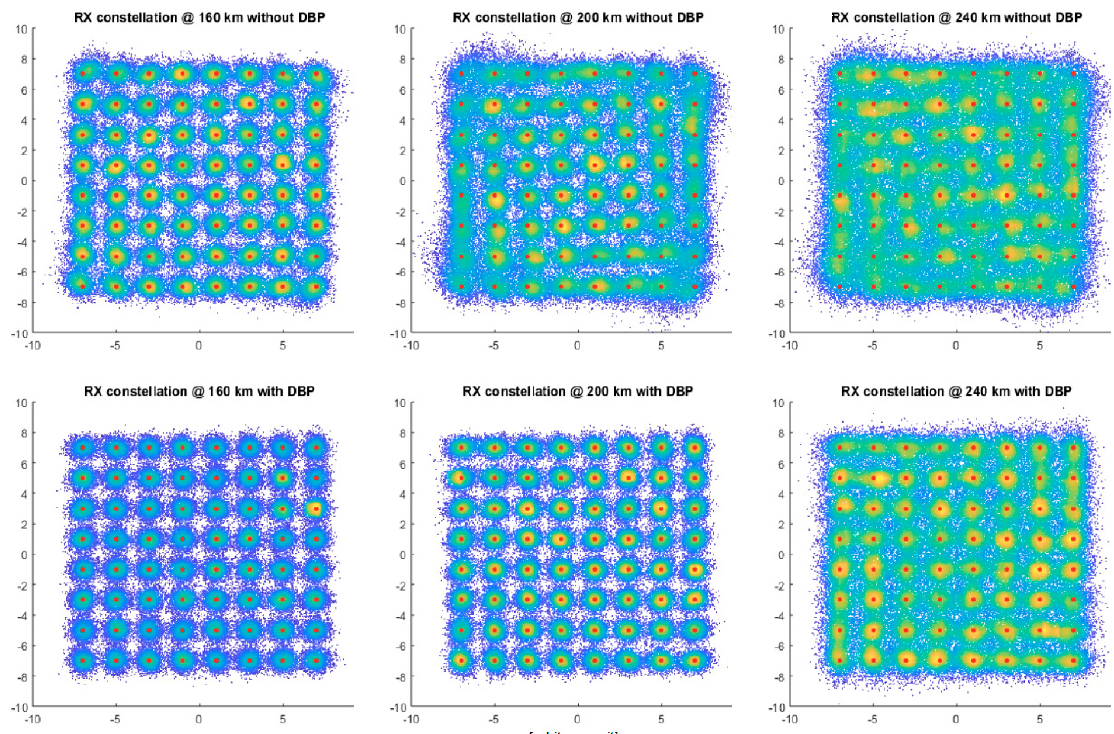
Figure 8. Constellation diagrams showing the simulation of best-case results assuming an ideal launch signal with (bottom) and without (top) applying DBP.